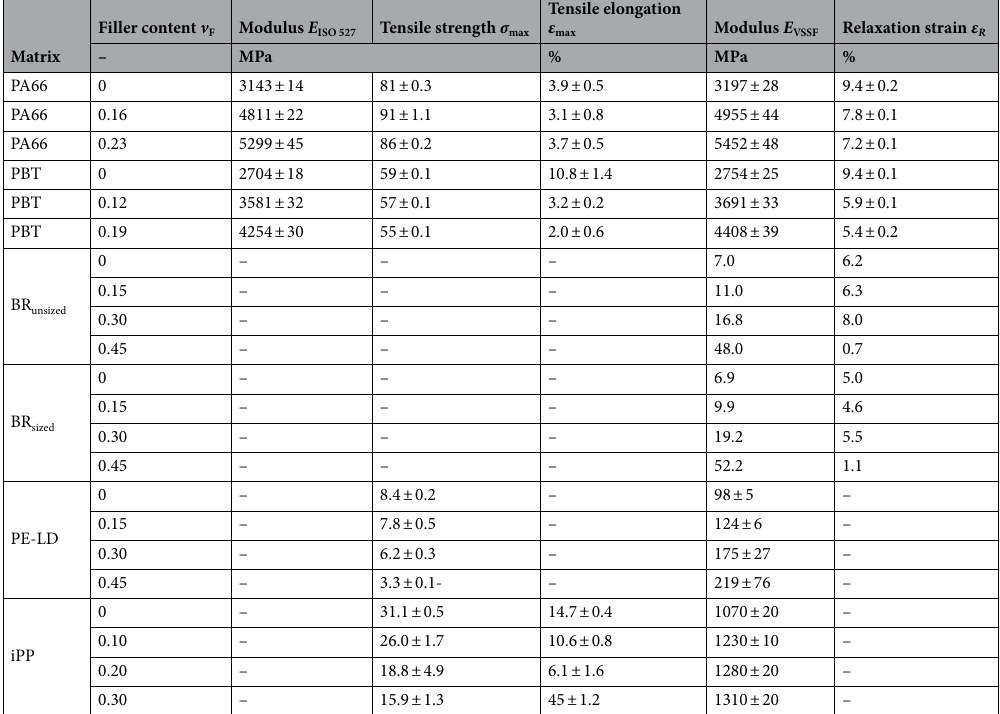
Table 3. Tensile properties of composites. For BR compounds the standard deviation could not be determined because there was only one stress strain curve for each compound available in Lohrmann 32 . For PE-LD and iPP the data were taken directly from Chimeni et al. 33 and Balkan and Demirer 34